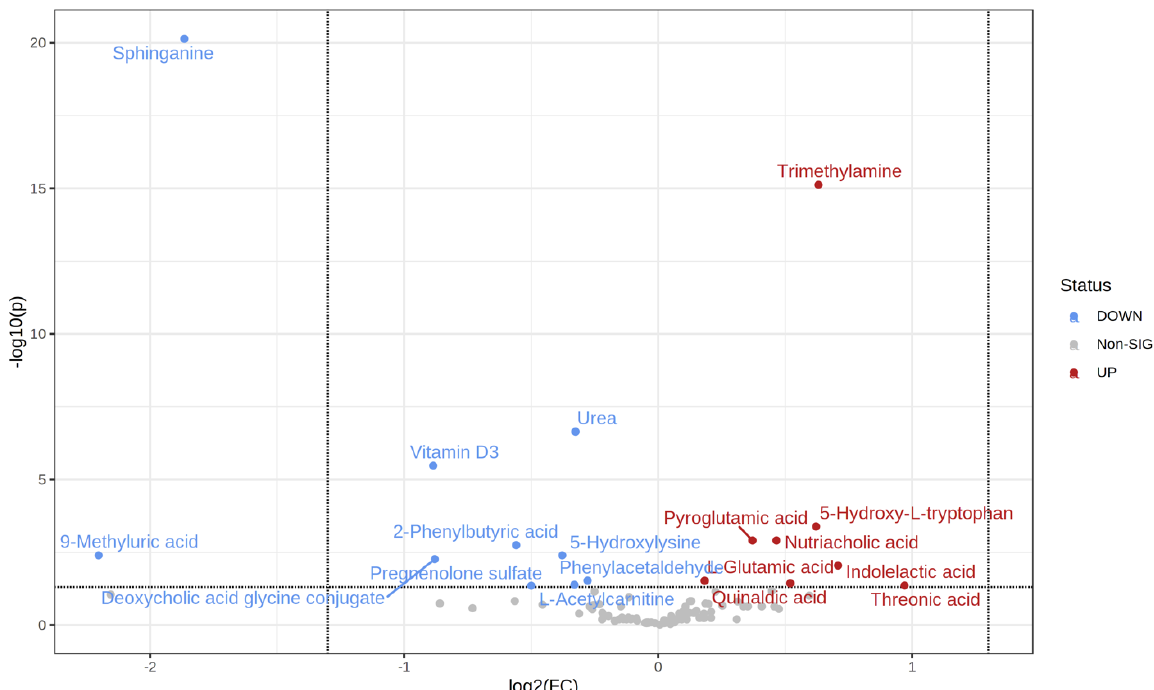
Figure 4. Volcano plot of the normoglycemic MetS and the prediabetic MetS groups.